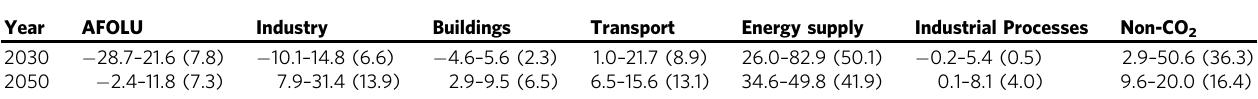
Fig. 2 Contribution of each sector to emission reductions between the NDCplus and Bridge scenario (negative values denote an increase in emissions between NDCplus and Bridge, and are indicated with hashes). First bar: Emissions by sector in 2015. Second bar: emissions by sector in 2030 (panel a) and 2050 (panel b), under NDCplus. Third — ninth bar: emission reduction in AFOLU (Agriculture, Forestry, and Other Land Use), industry, buildings, transport, energy supply, industrial processes, non-CO 2 emissions. Last bar: emissions by sector in 2030 (panel a) and 2050 (panel b), under Bridge. The IMAGE model is shown here as an illustrative example; full model ranges are shown in Table 2, while individual model results are shown in the SI (Supplementary Fig. 5). In addition, Supplementary Fig. 6 shows the sectoral contributions to emission reductions between the Bridge and 2Deg2020 scenarios in Table 2 Share of sector in total GHG reduction from NDCplus to Bridge scenario (%), model range: minimum — maximum (median). AFOLU: Agriculture, Forestry, and Other Land Use.